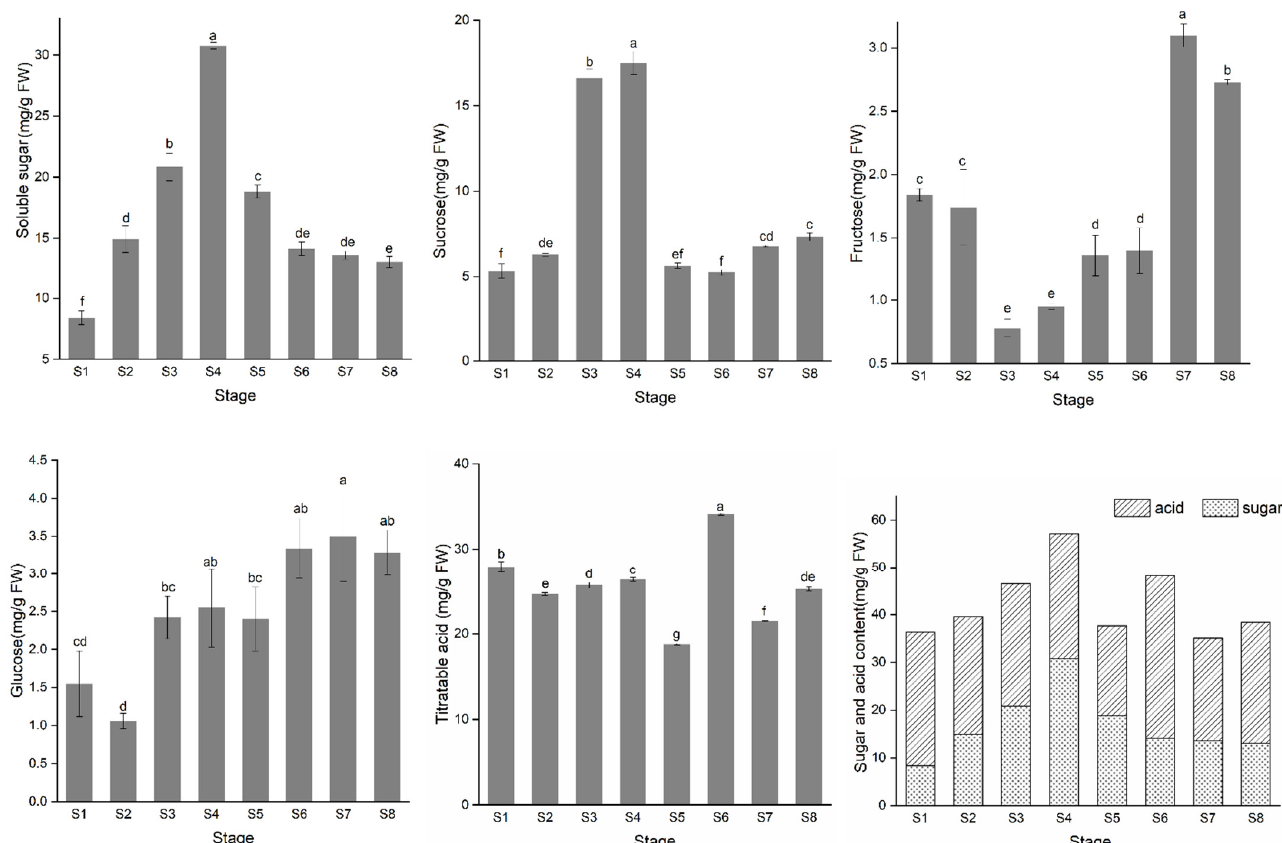
Figure 2. Changes in sugar and acid content at different developmental stages of stems. Vertical bars with different letters (a–e) indicate significant differences at the 0.05 level. Three biological replicates were performed for each index.